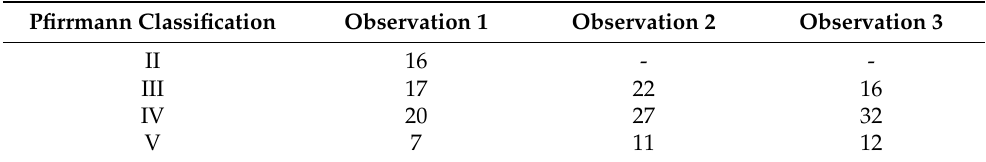
Table 3. Pfirrmann classification of degenerated discs in the investigated patients, determined by two observers. Observation 1 and 2 were performed at different time points by one observer with a time delay of 4 weeks, observation 3 were performed by a second observer.